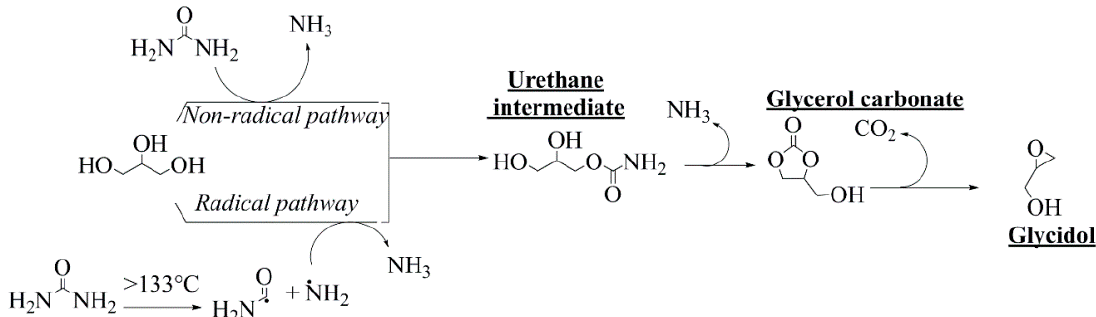
Figure 1. Radical and non-radical reaction pathways for formation of glycerol carbonate and glycidol during urea glycerolysis.